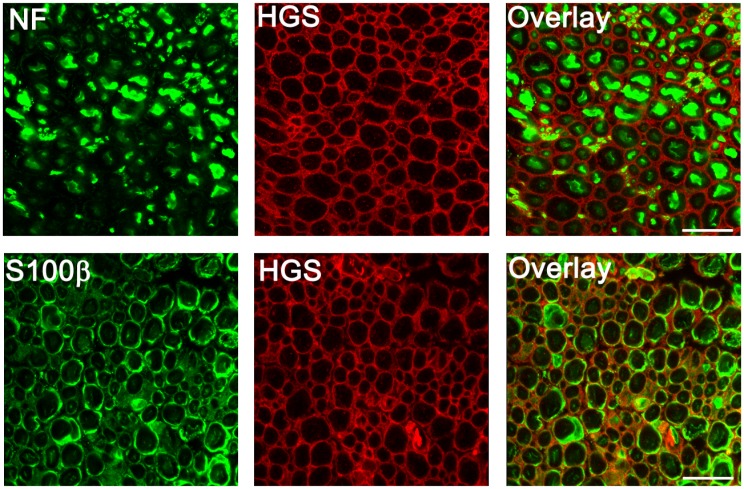
Distribution of HGS in sciatic nerves of 4-week-old Hgs
+/+mice.Top panel, cross sections of sciatic nerves stained with antibodies against neurofilament (NF, green) and HGS (red). Bottom panel, sciatic nerves were stained with antibodies to the Schwann cell marker S100β (green) and HGS (red). Scale bar, 10 μm.